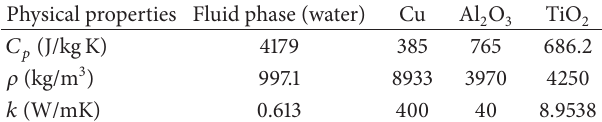
Table 1: Thermophysical properties of fluid and nanoparticles [29]. Physical properties Fluid phase (water)